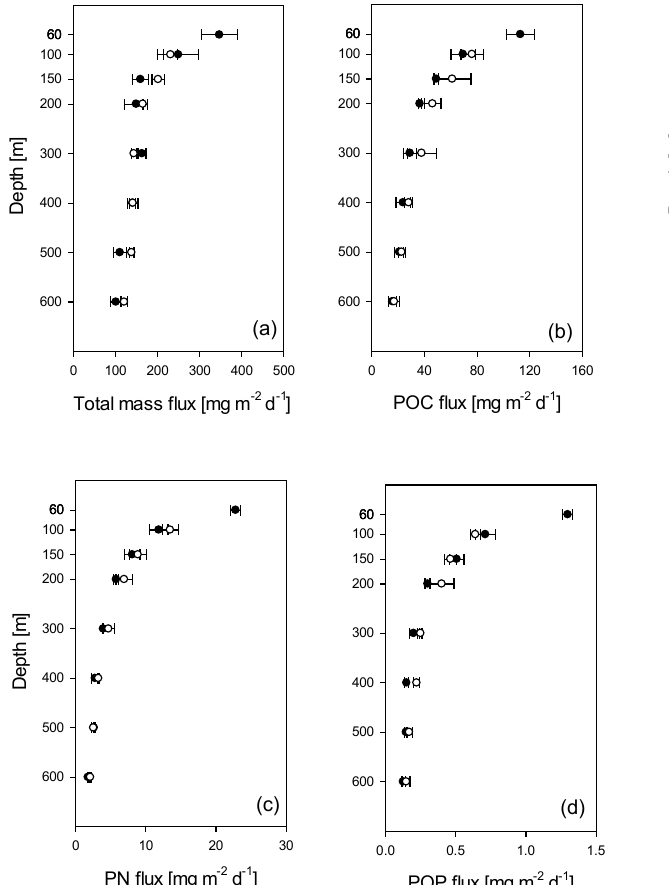
Figure 2. Fluxes of (a) total mass and (b) particulate organic car- bon (POC), (c) particulate nitrogen (PN) and (d) particulate or- ganic phosphorus (POP) during the deployment of two STDT in the ETNA. Solid symbols are used for deployment no. 1 and open symbols for deployment no. 2.